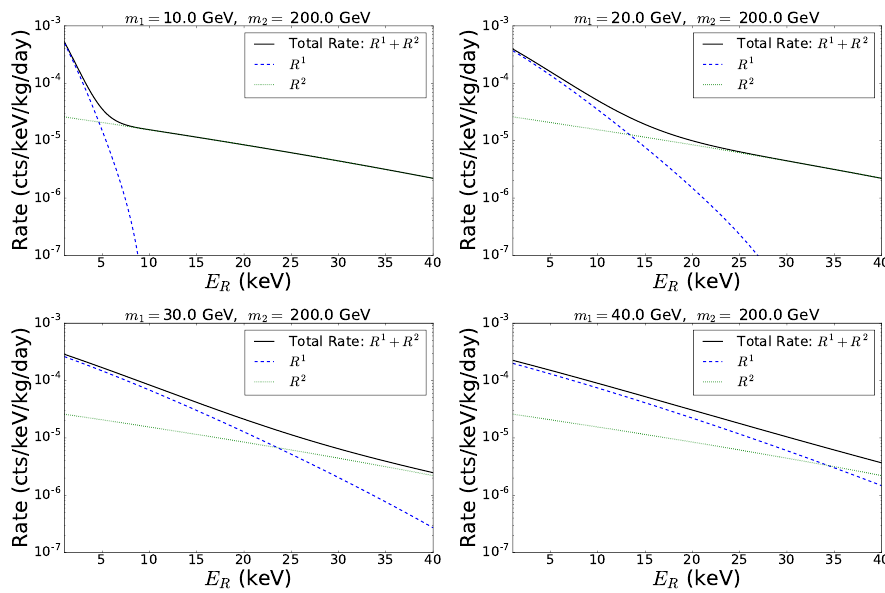
Figure 1. Total di ff erential event rate for 2 DM particles (solid black), as well as their individual contributions (1 dashed blue, 2 dotted green) for a variety of DM mass splittings on the energy range [2 , 30] keV. One should notice that the kink feature in the combined spectrum rapidly vanishes with smaller mass